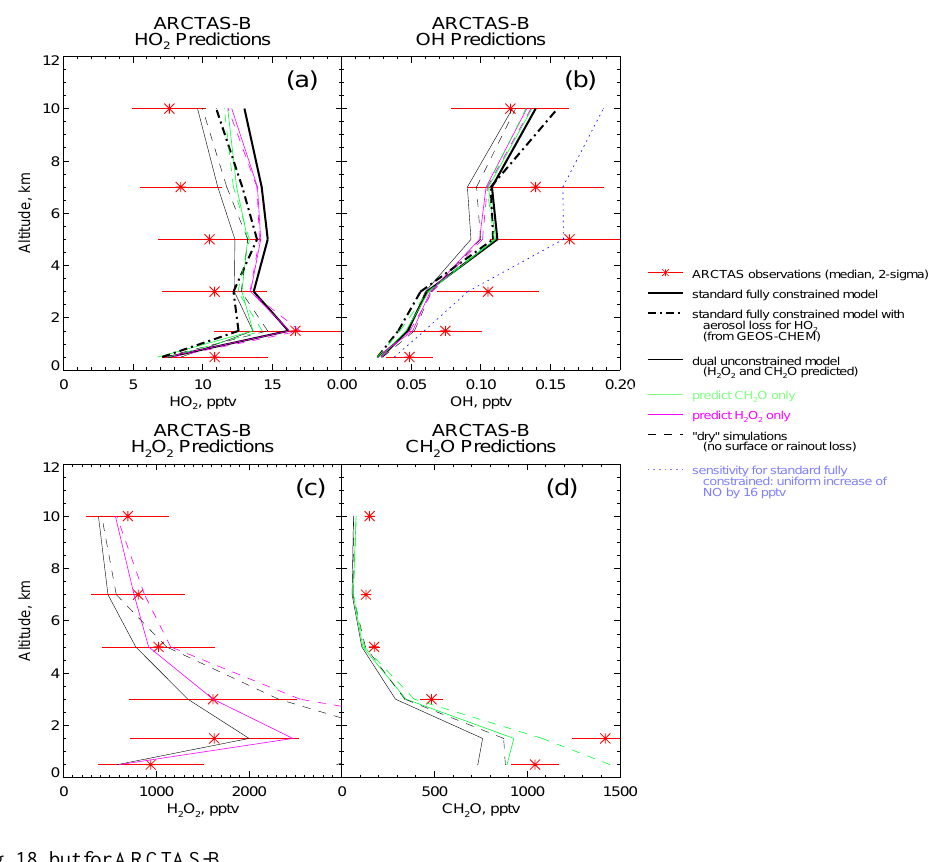
Fig. 19. As in Fig. 18, but for